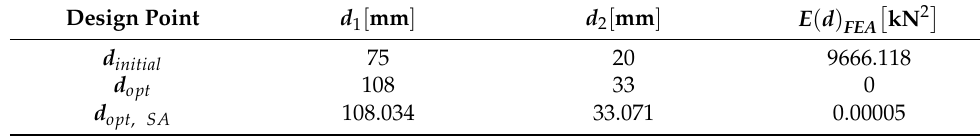
Table 10. The optimal design variables found by the simulated annealing